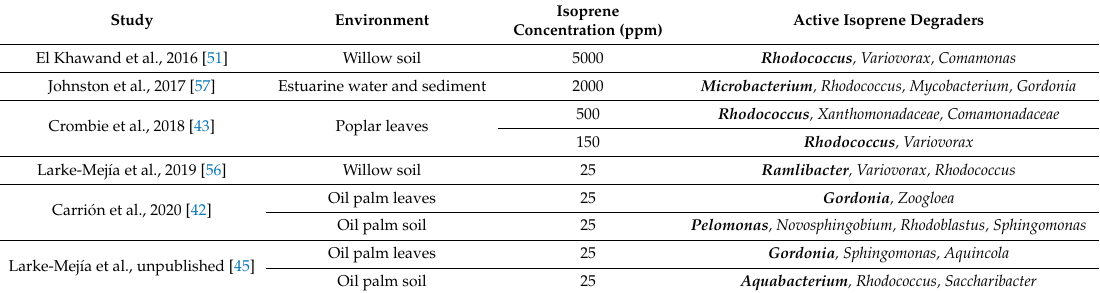
Table 1. Isoprene-degrading bacterial community from terrestrial, phyllosphere, and estuarine environments identified by DNA Stable-Isotope Probing (DNA-SIP). The dominant genus in each environmental sample incubated with 13 C-isoprene is indicated in